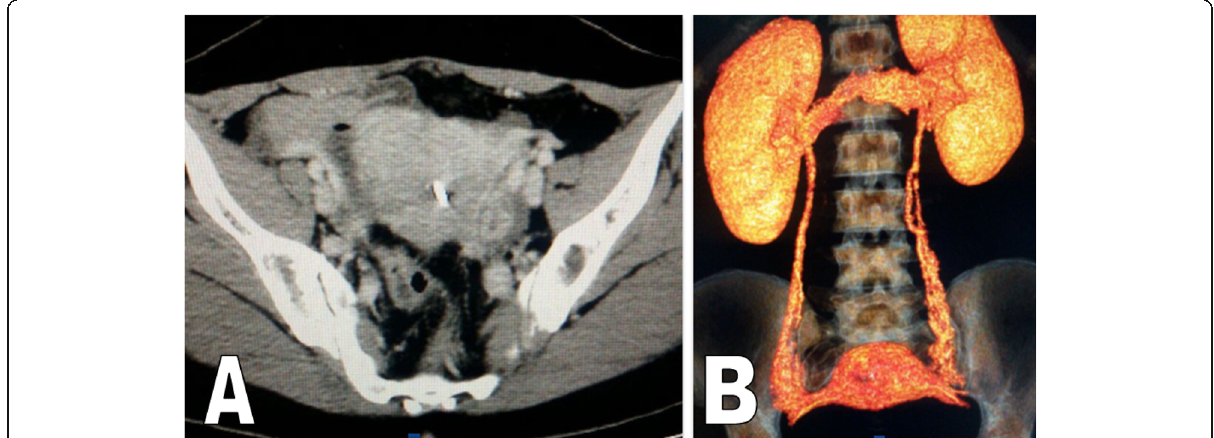
Fig. 2 a Axial CTV of the pelvis showing multiple dilated and congested parametric and ovarian veins. b 3D VR CTV of the abdomen and pelvis showing dilated both ovarian veins along their